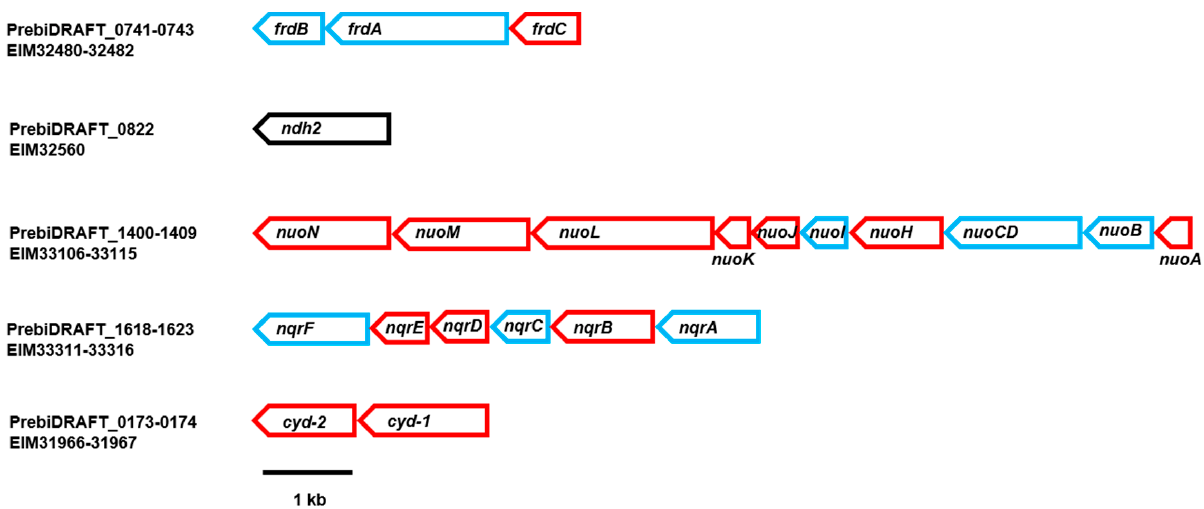
Figure 5. Genes coding for membrane-bound electron transfer complexes of P. bivia . ORF (PrebiDRAFT) and NCBI accession numbers (EIM) are given on the left. The fumarate reductase (QFR) was encoded by frdA (1983 bp), frdB (675 bp), and frdC (756 bp). The non-electrogenic NADH dehydrogenase (Ndh2) is a membrane-associated enzyme encoded by ndh2 (1308 bp; black frame). The nuoA (351 bp), nuoB (906 bp), nuoCD (1578 bp), nuoH (1098 bp), nuoI (534 bp), nuoJ (534 bp), nuoK (309 bp), nuoL (2061 bp), nuoM (1512 bp), and nuoN (1440 bp) genes are similar to the genes coding for the corresponding subunits of the 11-subunit complex related to the NUO complex. The Na + -translocating NADH:quinone oxidoreductase (NQR) was encoded by nqrA (1359 bp), nqrB (1161 bp), nqrC (714 bp), nqrD (633 bp), nqrE (627 bp), and nqrF (1263 bp). The cytochrome bd quinol oxidase was encoded by cyd-2 (1143 bp) and cyd-1 (1536 bp). Red frames correspond to genes coding for hydrophobic (membrane-bound) subunits. Blue frames correspond to genes coding for hydrophilic (peri or cytoplasmatic) subunits.